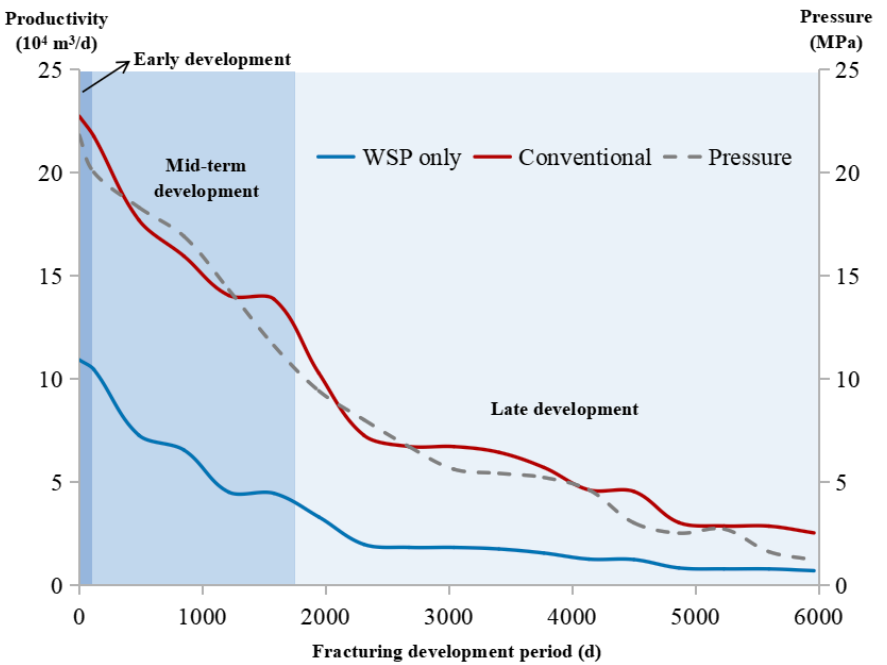
Figure 9. Influence of pollution on gas reservoir production under the condition of only water solvent pollution from fracturing water.